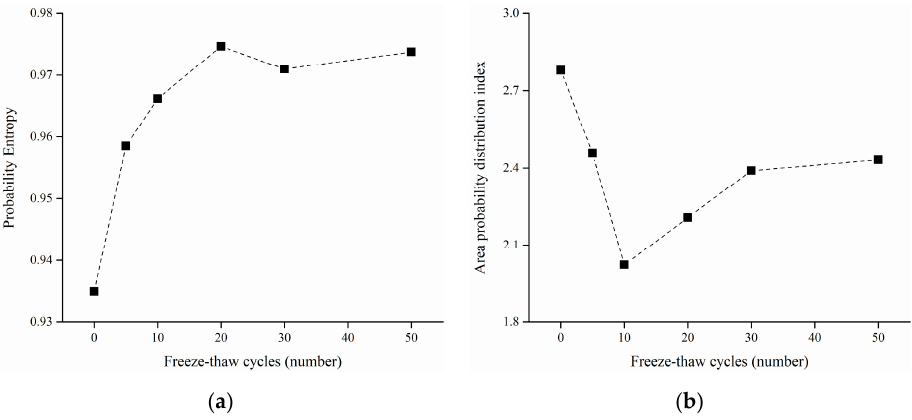
Figure 9. Fractal dimension. ( a ) Probability entropy, ( b ) Area probability distribution index.